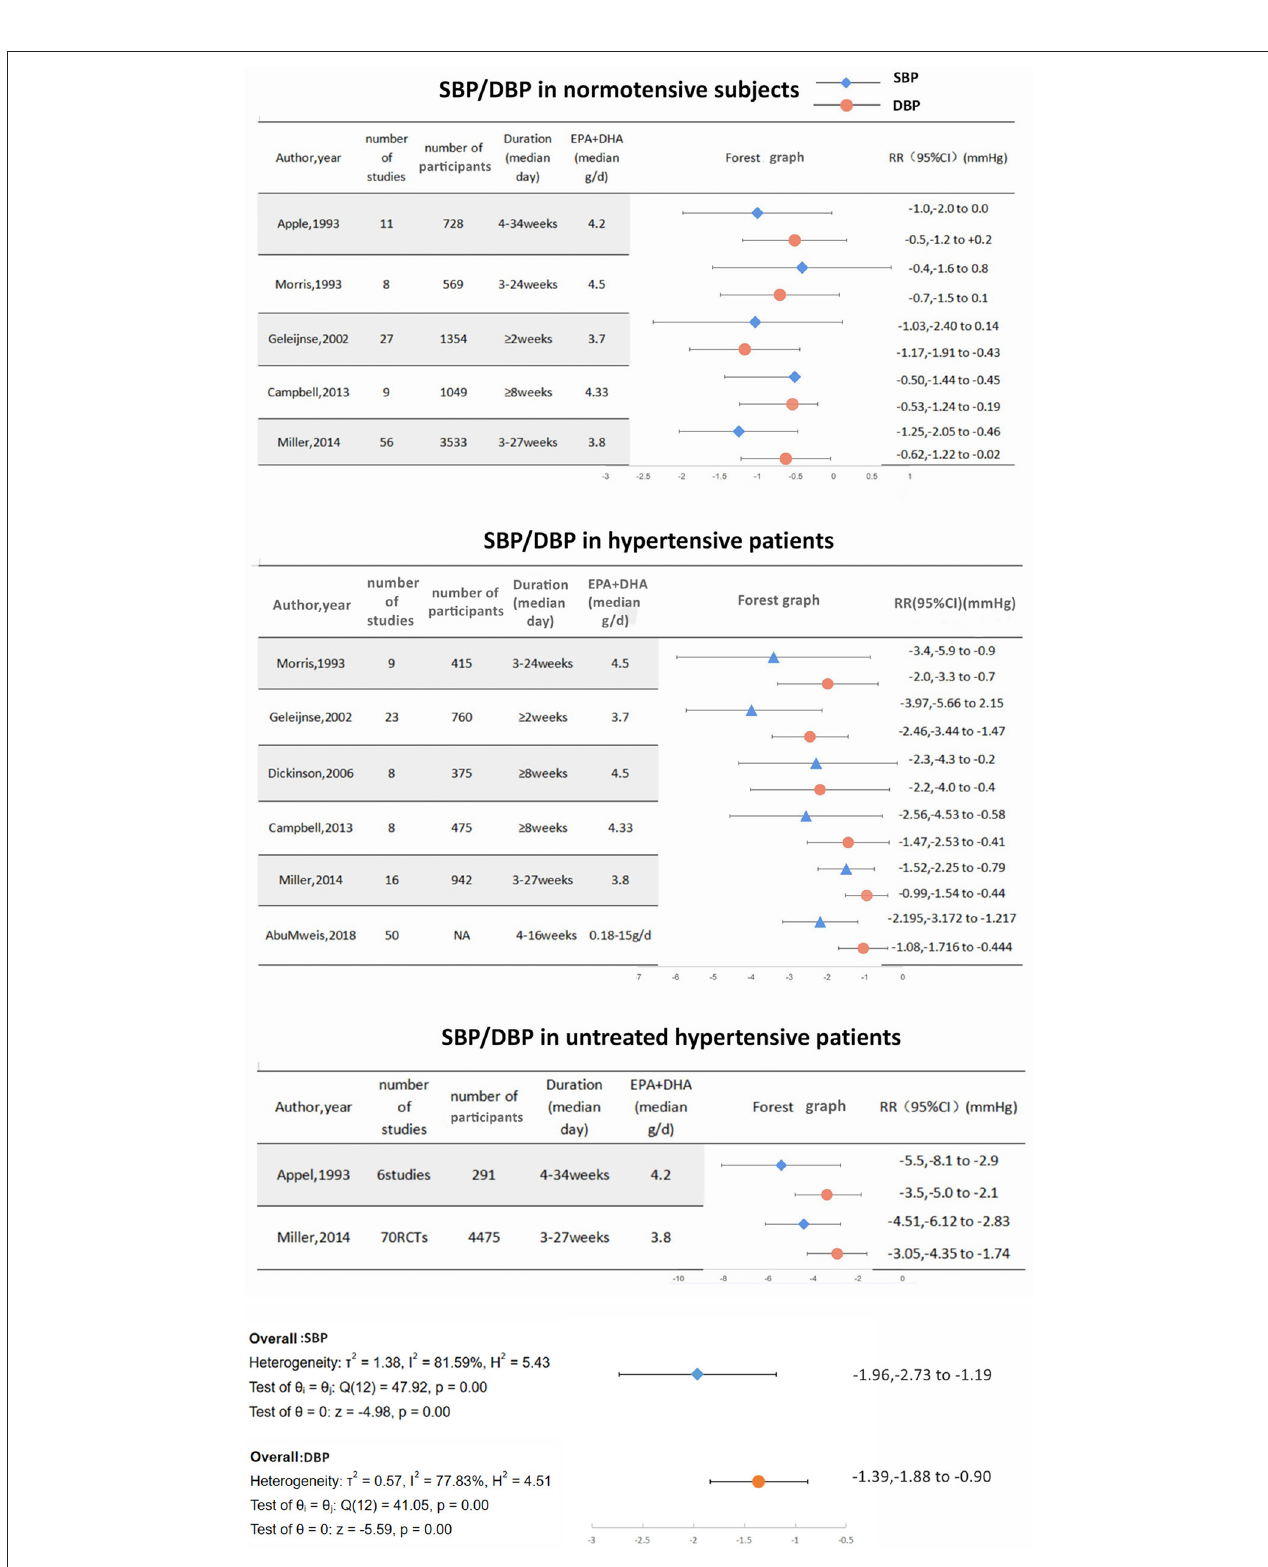
FIGURE 3 | The effect of ω -3 PUFAs consumption on blood pressure in normotensive subjects/ patients with hypertension/ patients with untreated hypertension.